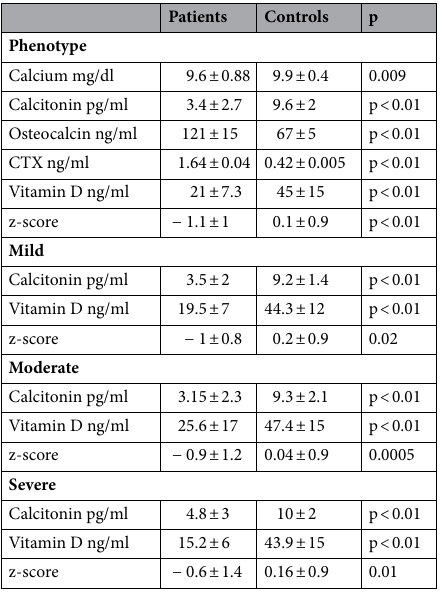
Table 3. Biochemical markers of bone metabolism and bone mineral density in patients and